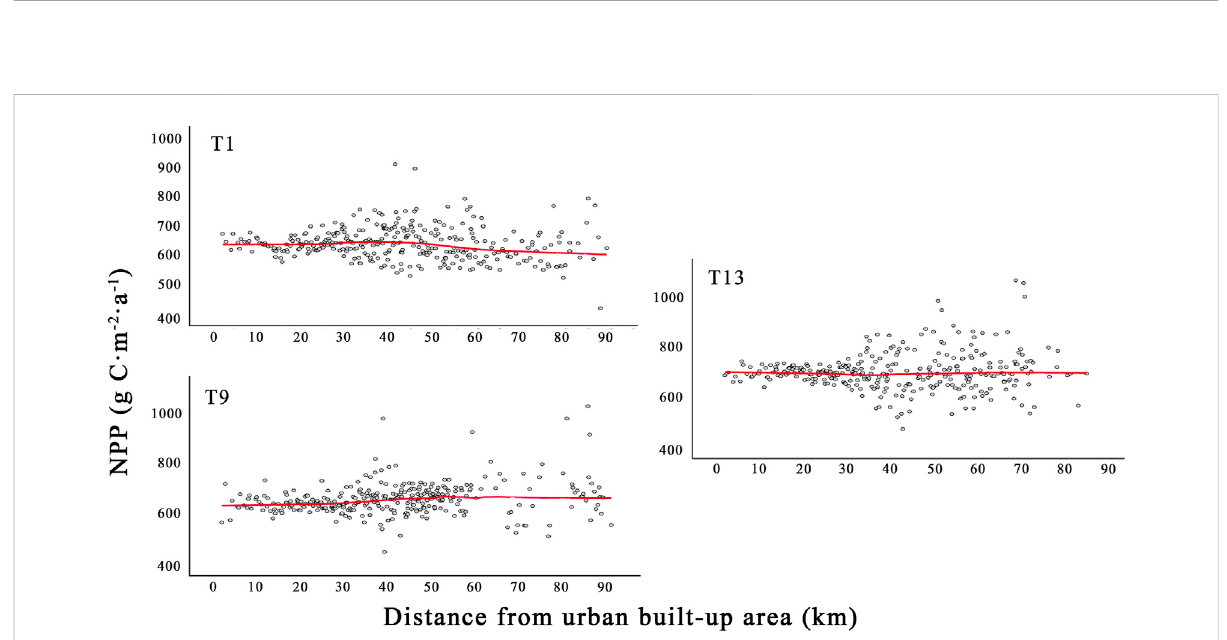
FIGURE 8 No signi fi cant relationships between NPP supply capacity and distance from built-up